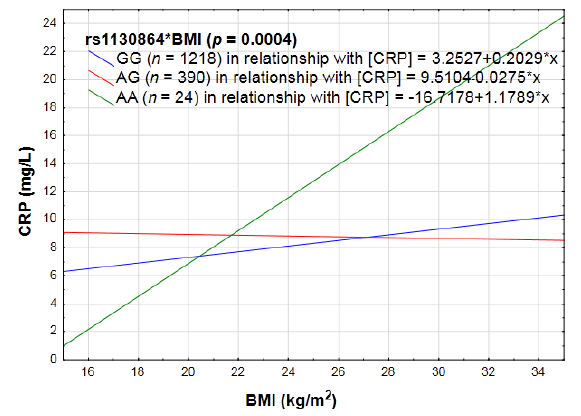
Figure 1. Example portraying the linear relationship between an anthropometrical variable, body mass index (BMI), with CRP concentrations categorized for